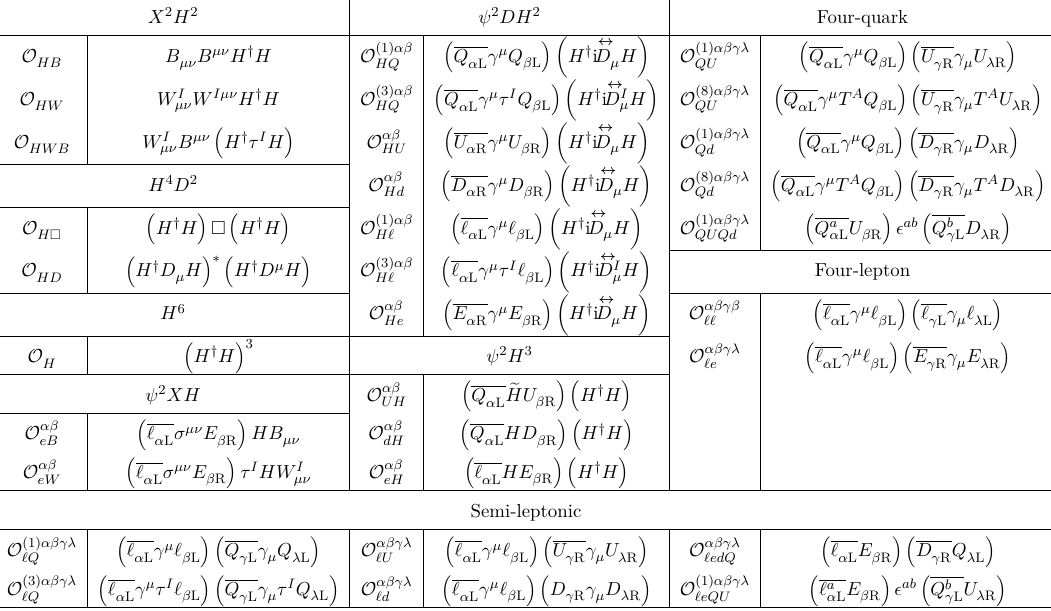
Table 2 . Dimension-six operators induced by the type-I seesaw model at the one-loop level in the Warsaw basis, where the Hermitian conjugates of the operators in classes ψ 2 XH and ψ 2 H 3 , as well as those of the four-fermion operators, have not been listed